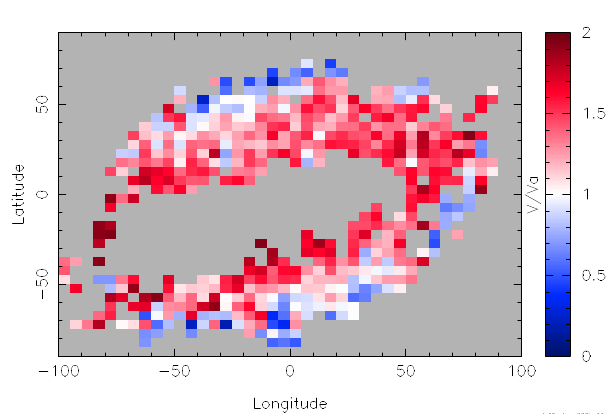
Fig. 10. Alfv´en Mach numbers, M A , measured by Cluster in the magnetosheath over the mission period January 2001-May 2004. Each measurement has been placed in a 5 × 5 ◦ angular bin of GSM longitude and latitude. The tiles are coloured according to their value indicated on the adjacent colour bar and represent an average over all measurements which fall into a particular 2-D geocentric angular bin. The scale indicates red values for super-Alfv´enic flow and blue for sub-Alfv´enic flow. Here we see clearly that the flow at the highest and lowest latitudes is sub-Alfv´enic whilst the flow tends to be super-Alfv´enic at mid-latitudes and at the flanks of the